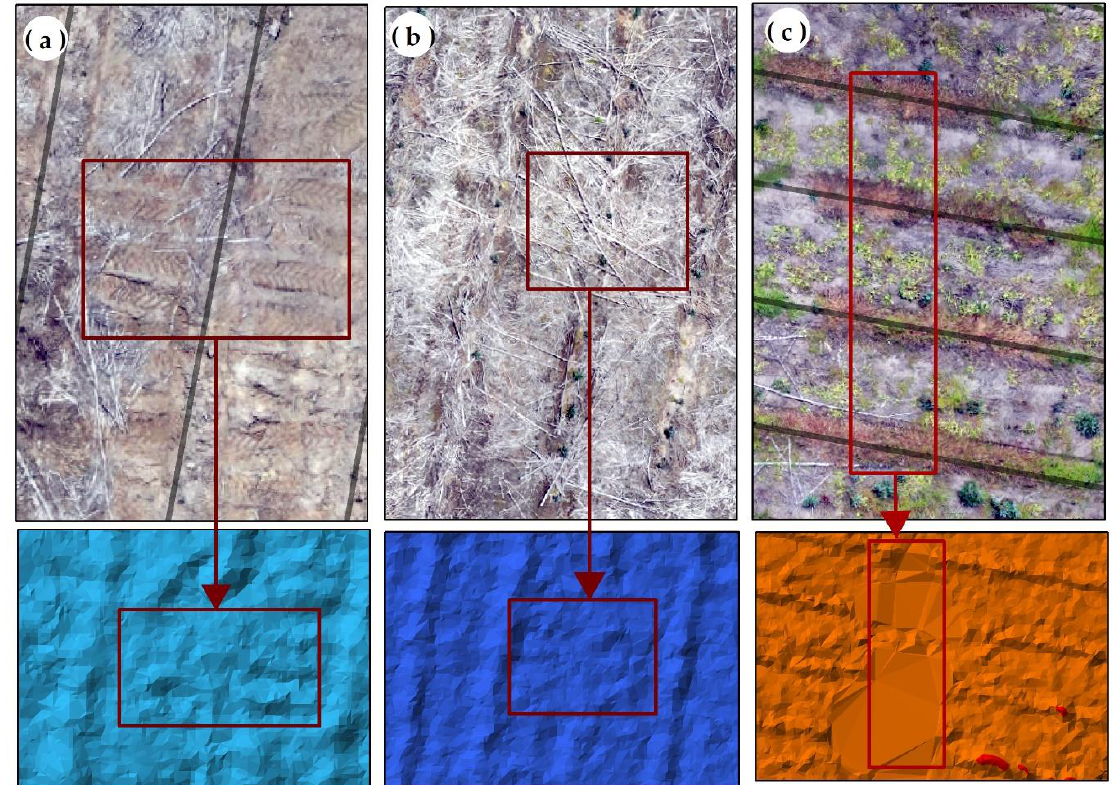
Figure 13. Illustration of compromised plantation rows in DIPC-based DSM: ( a ) damaged rows by machines; ( b ) The plantation rows buried under dead plantation of the previous crop; ( c ) plantation rows dominated by weeds and grass. The adequate points were not constructed by SfM software.